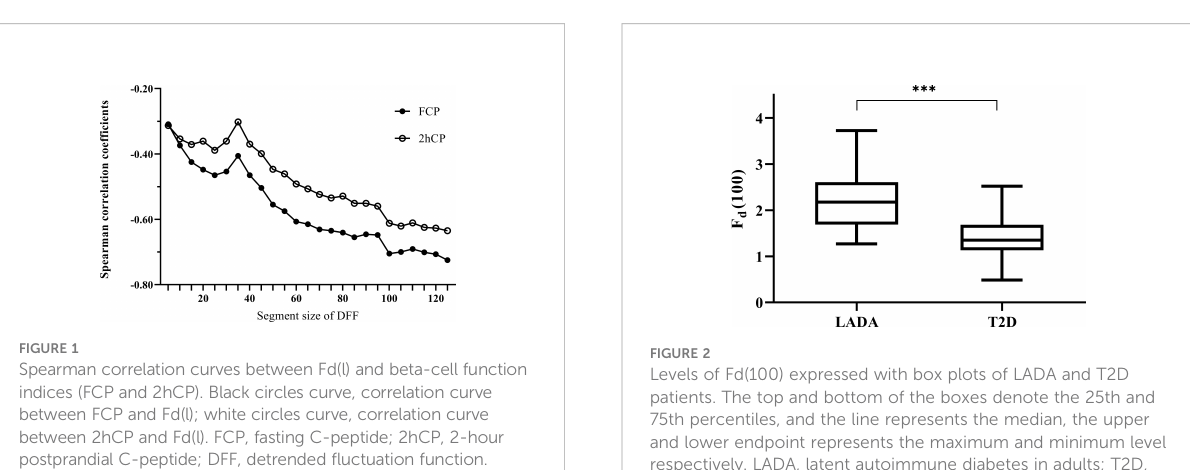
TABLE 2 Correlation between glycemic parameters and C-peptide levels.